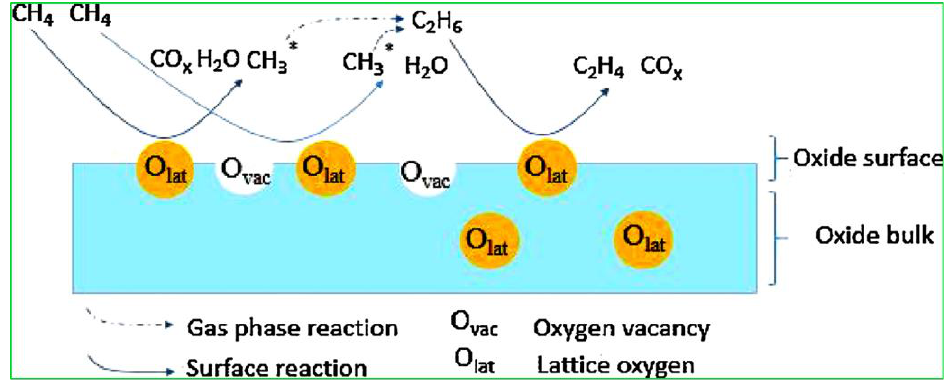
Figure 2. Diagrammatic representation of oxidative coupling of methane (OCM) reaction on a metal oxide catalyst surface. Reproduced with permission from [19] . Copyright 2018 Elsevier. oxide catalyst surface. Reproduced with permission from [19]. Copyright 2018